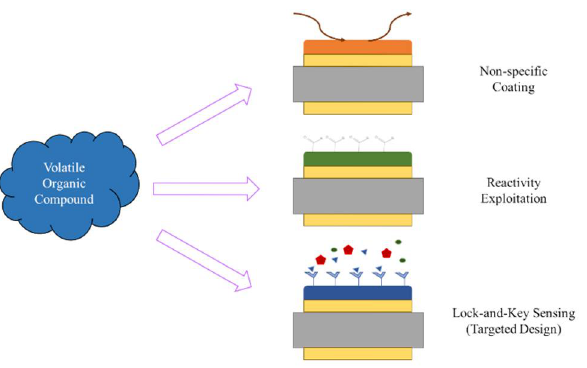
Figure 5. Selectivity mechanisms of various coatings commonly employed in QCM